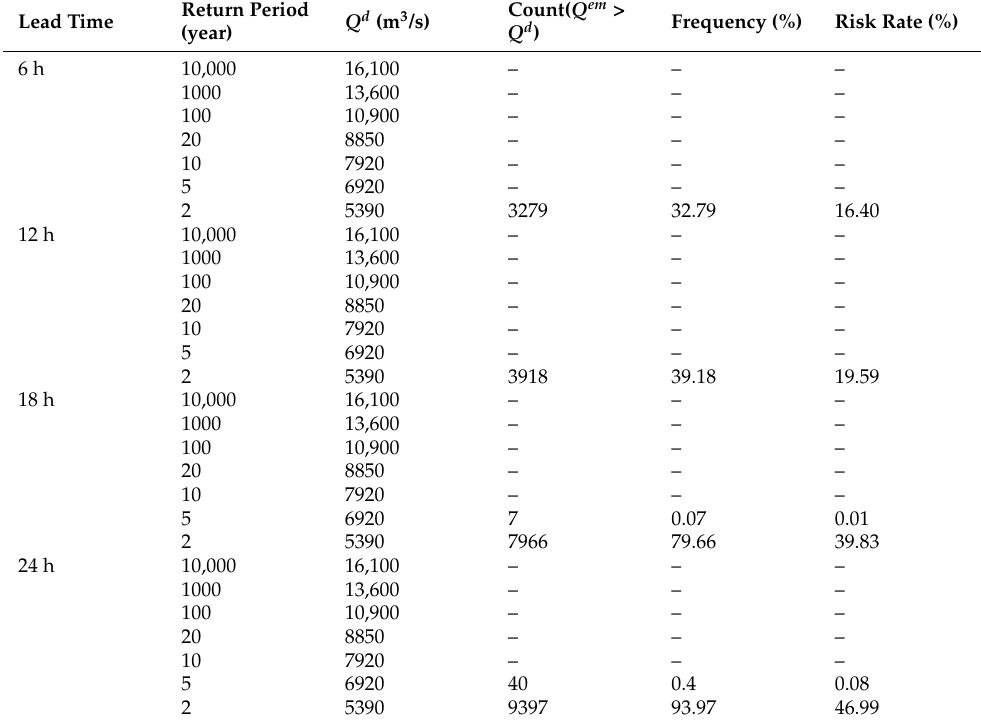
Table 3. Flood risk rates of the forecasted ensemble inflows while taking the IFU into